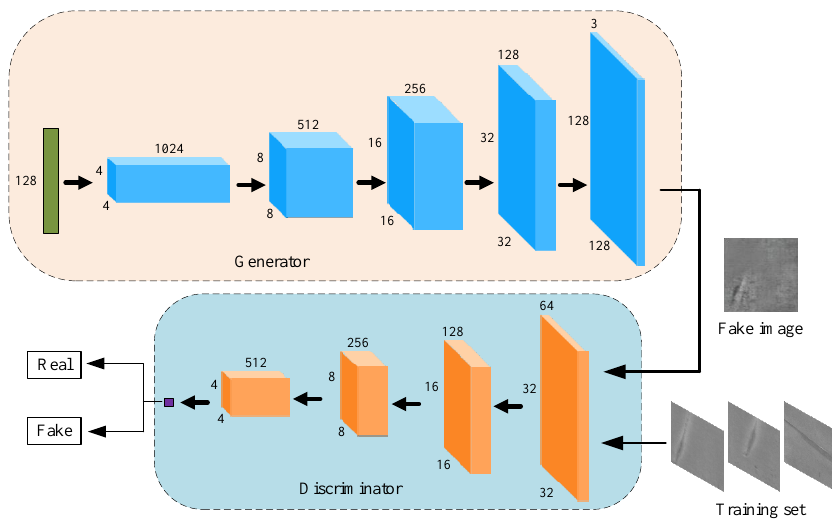
Figure 3. The proposed WGAN